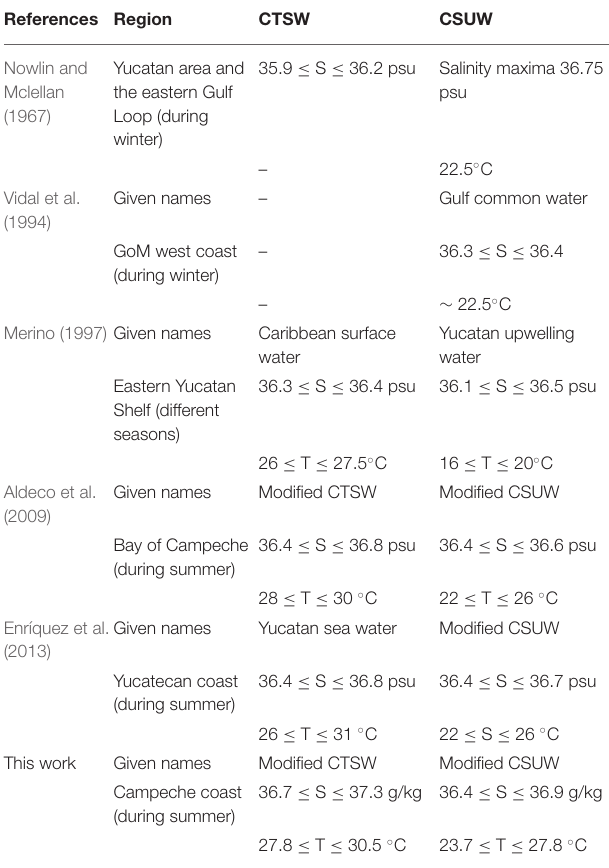
TABLE 2 | Reported T and S intervals for CTSW and CSUW, for different seasons and regions within the GoM. References